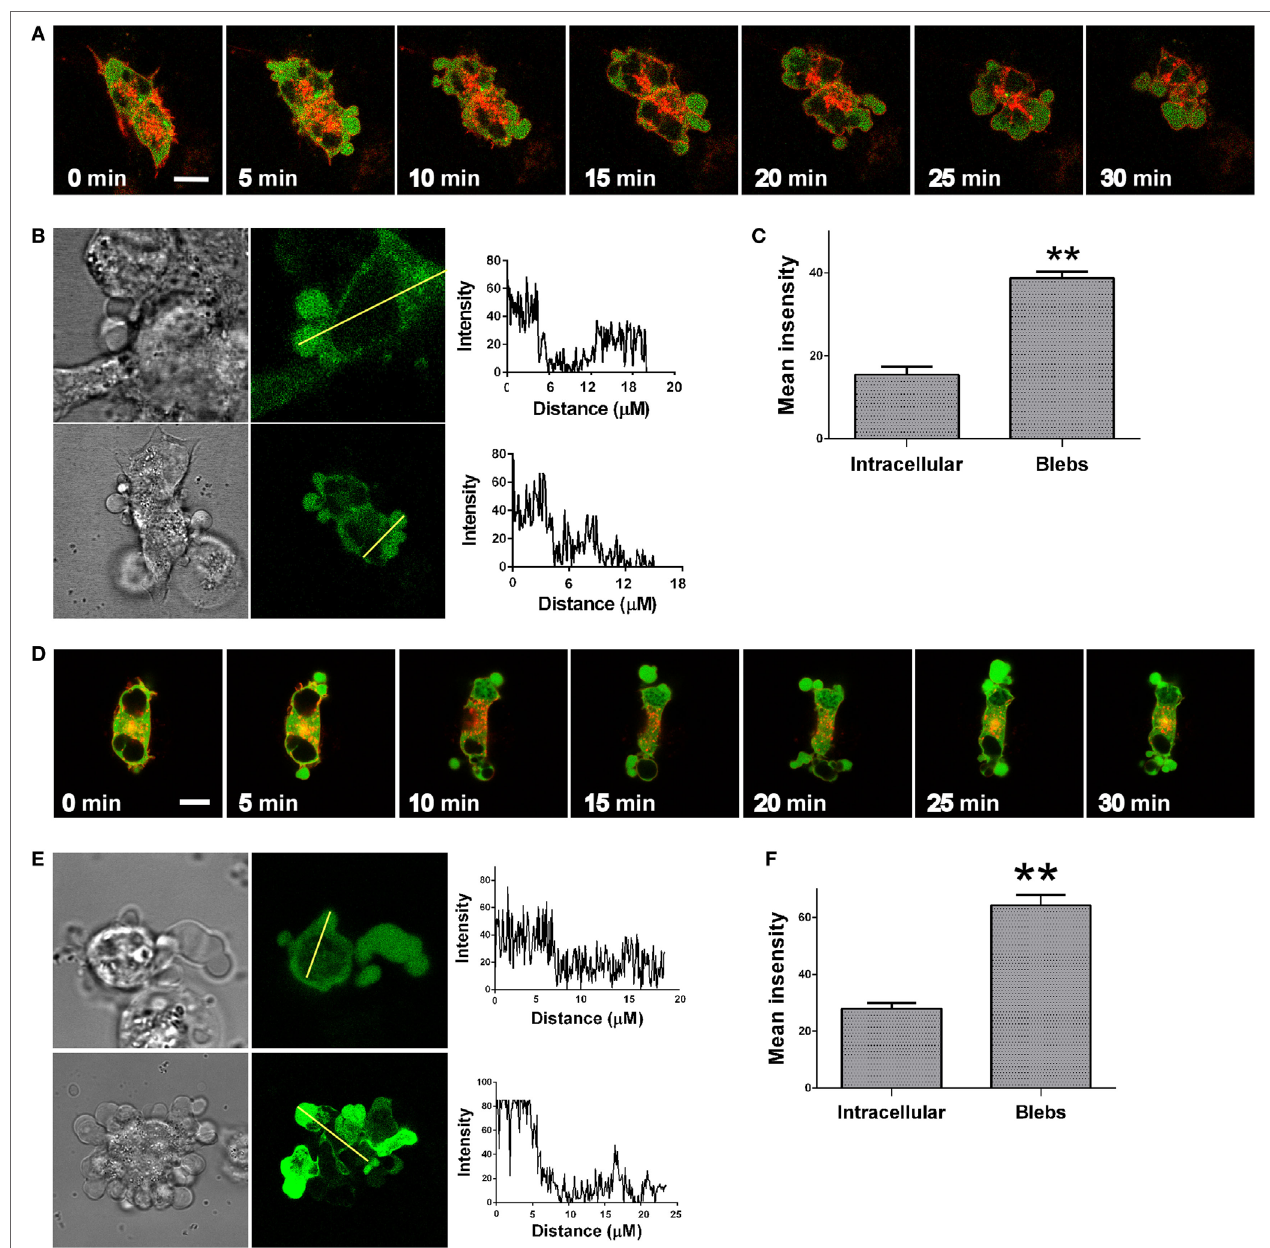
FigUre 6 | Focal adhesion kinase (FaK) and paxillin are present in the blebs . (a) Addition of GnRH (0–30 min, 10 nM) to serum-starved L β T2 cells transfected with GnRH receptor (GnRHR)-mCherry and FAK-GFP resulted in bleb formation, while FAK is present in the blebs. The scale bar is 10 µm. (B) Blebs images after GnRH treatment, including DIC and fluorescent images of FAK-GFP. Fluorescence intensity was measured across the cells and intensity profiles are shown on the right. (c) Quantitation of FAK-GFP mean fluorescence intensity in the blebs vs. intracellular area from multiple scanning of each cell from at least five experiments. The bars are mean ± SEM. ** p -Value ≤ 0.01. (D) Addition of GnRH (30 min, 10 nM) to serum-starved L β T2 cells transfected with GnRHR-mCherry and paxillin-GFP resulted in bleb formation, while paxillin accumulates in the blebs. The scale bar is 10 µm. (e) Blebs images after GnRH treatment, including DIC and fluorescent images of paxillin-GFP. A line intensity profile across the cells was obtained and intensity profiles are shown on the right. (F) Histograms show mean ± SEM of fluorescence intensity of the blebs vs. intracellular area from multiple scanning of each cell from at least five experiments. ** p -Value ≤